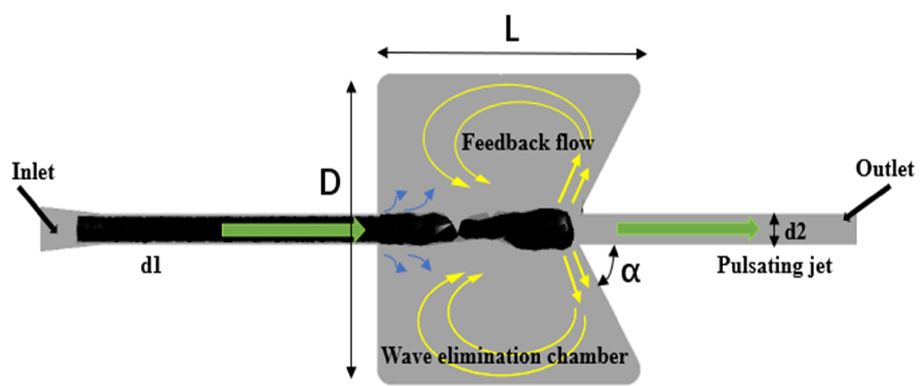
Figure 1. Schematic diagram of a Helmholtz wave-elimination chamber.